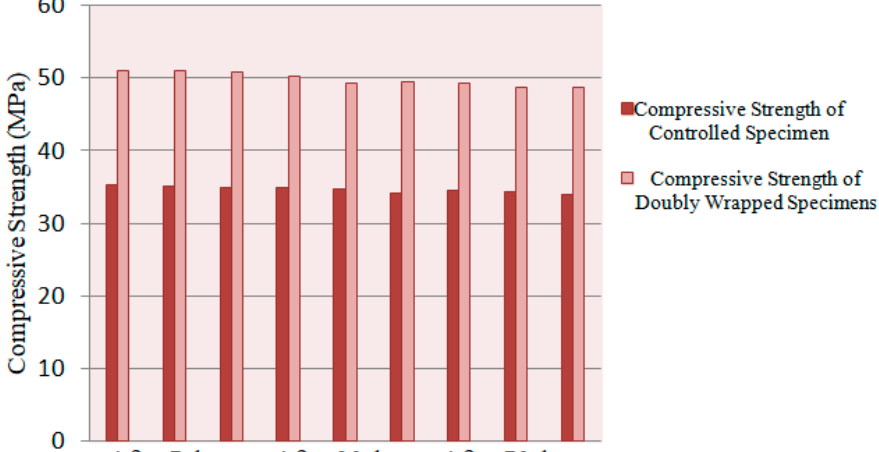
Figure 3. Weight loss in the acid resistance test.